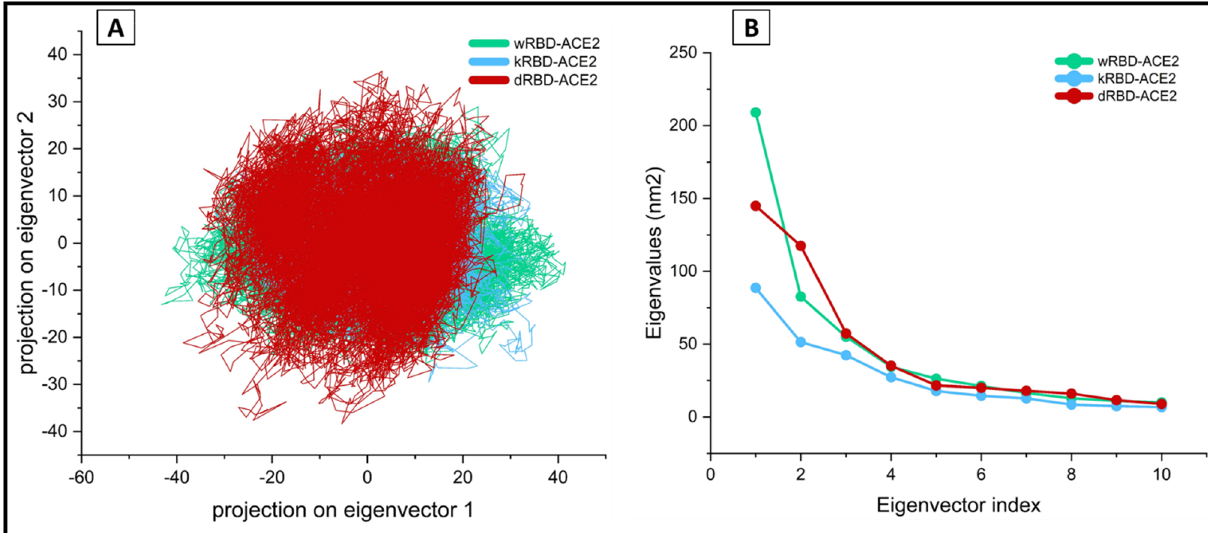
Figure 4. ( A ) The 2D eigenvector projection plot showing the differences in the dynamic fluctuations of the wtRBD (green), kRBD (blue), and dRBD (red) complexes of SARS-CoV-2 with the ACE2 ( B ) the plot for the eigenvalues for the top 10 selected vector.